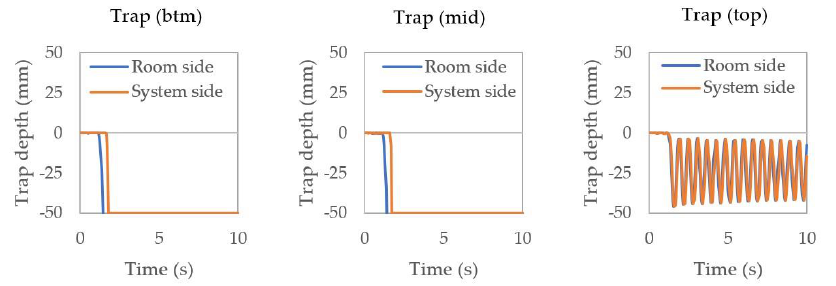
Figure 9. Simulated elements of operational performance, including the stack pressure profile, airflow, and resultant trap retention depth for the 10 story building as a single-stack system with ( a ) 100 mm diameter stack and ( b ) 150 mm diameter stack.